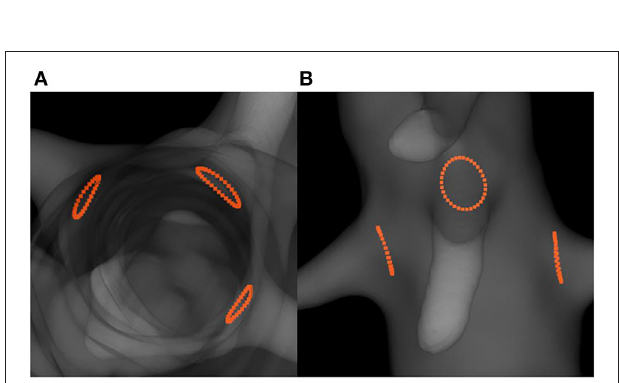
FIGURE 8 | Simulation results showing the predicted positions of fenestrations with respect to the target ostia: top cross-section view (A) and frontal view (B)